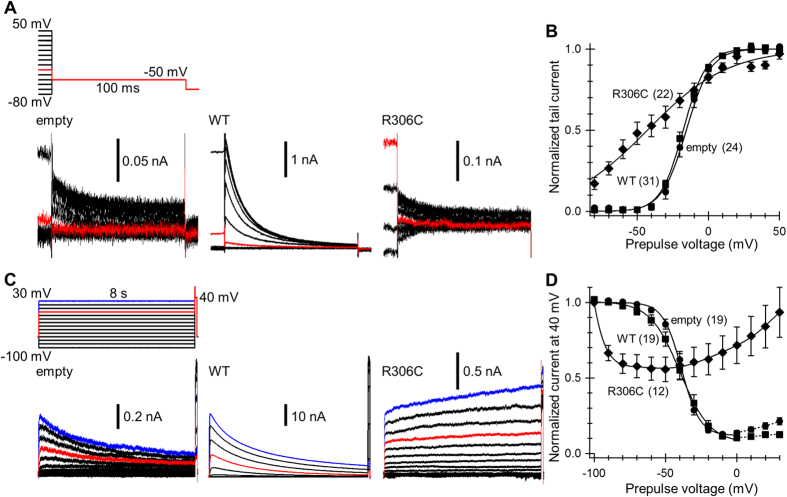
Voltage dependence of activation and inactivation of Kv currents in transfected Neuro2a cells.(A) Representative tail currents. Traces from the last 10 ms of 200 ms voltage steps are shown. Currents elicited by the step from –30 mV are highlighted in red. (B) Activation curves of endogenous Kv2 (empty; circles), WT (squares), and R306C (diamonds). Vh and Vs in empty (−15.6 ± 2.2 mV and 7.0 ± 0.7 mV, respectively) did not differ statistically from those in WT (Vh −17.4 ± 1.3 mV, P = 0.85; Vs 6.9 ± 0.2 mV, P = 1.00 by Dunnett’s T3 test). Vh and Vs in R306C were −43.3 ± 5.6 mV and 25.7 ± 2.5 mV, respectively. (C) Representative currents evoked by long voltage steps. Currents evoked by the steps to 0 mV and +30 mV are highlighted in red and blue, respectively. (D) Inactivation curves of endogenous Kv2 (circles), WT (squares), and R306C (diamonds). Vh and Vs in empty were −38.7 ± 1.3 mV and 5.7 ± 0.2 mV, respectively, and in WT were −39.9 ± 2.7 mV (P = 0.68) and 7.3 ± 0.3 mV (P < 0.01 by 2-tailed Student’s t test), respectively. In R306C, the current after the prepulse to +30 mV (0.93 ± 0.33) was significantly larger than that after the prepulse to −50 mV (0.56 ± 0.08, P < 0.01 by 2-tailed paired Student’s t test). The numbers of cells analyzed are indicated in parentheses.